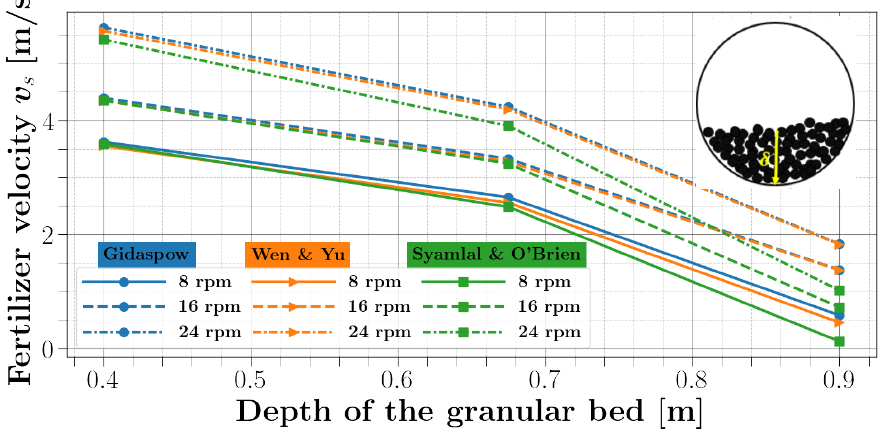
Figure 8. Particle velocity profile ( d = 2 mm) for 8, 16, and 24 rpm rotational speeds with different drag models tested, with a representative snapshot of the depth of the granular bed δ (distance from the drum bottom to the interface between the granules and